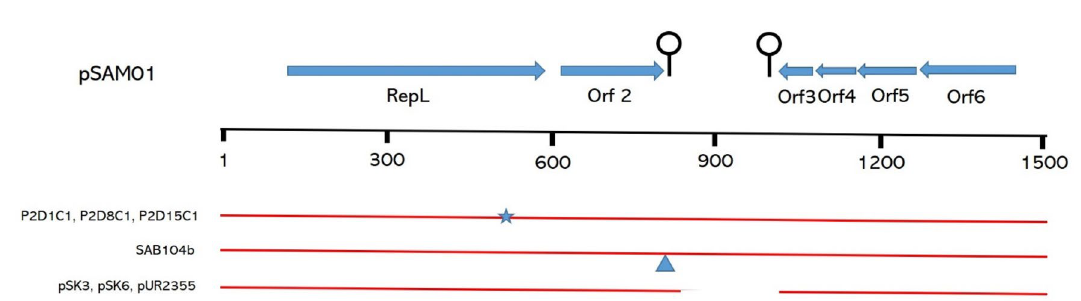
Figure 5. Schematic representation of open reading frames on plasmid pSAM1. The relative positions of open reading frames ( repL , 2, 3, 4, 5 and 6) are marked by arrows. Predicted stem-loop structures are indicated by lollypops. Regions of sequence identity between different plasmids are indicated by red lines, in which mutations (*) and insertions (∆) are marked. The names of the homologous plasmids are indicated on the left. The Figure was created with Microsoft PowerPoint